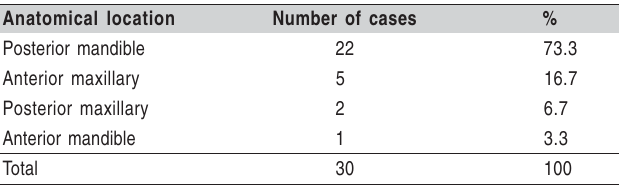
Table 4 - Distribution of cases of odontogenic cysts according to anatomical location. São Luís, MA-2010.